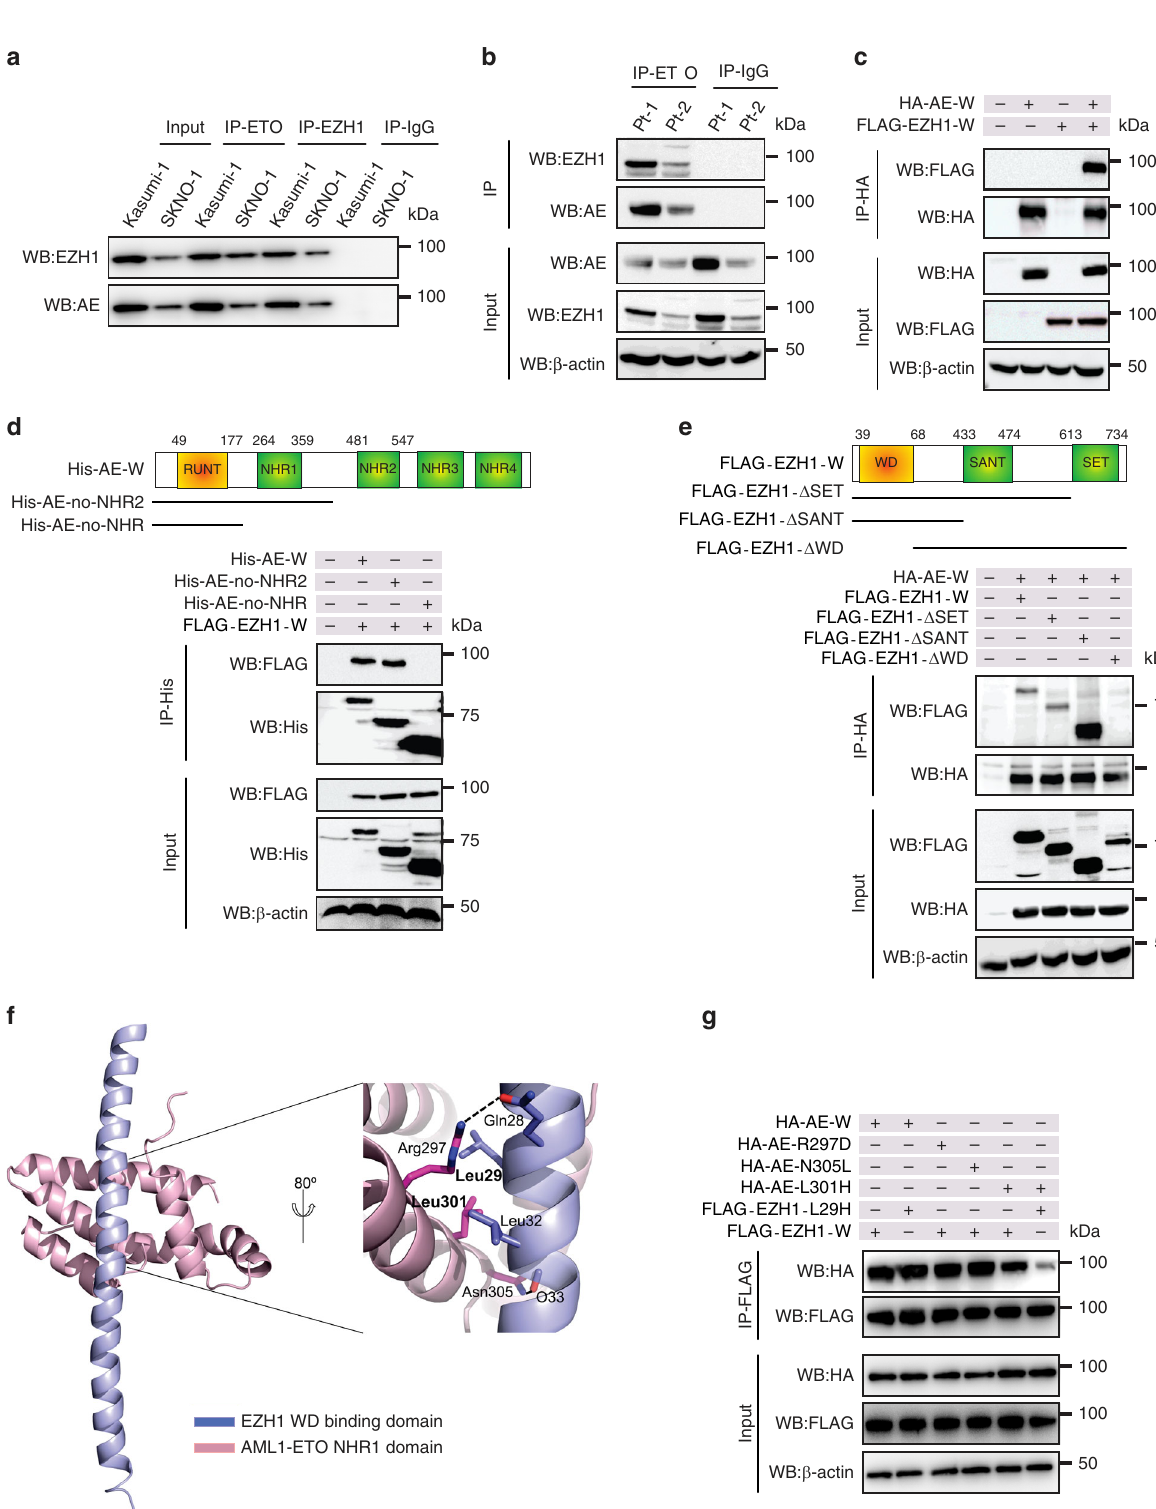
upper). The AML1-ETO pulldown with anti-His revealed a ETO itself can interact with EZH1, but no methylation was comparable lysine methylation for AML1-ETO full length detected in cells co-expressing FLAG-ETO-W (wild type) and His-EZH1-W (wild type) (Supplementary Fig. 4f). Moreover, (Fig. 4d, lane 1) and mutants with deletion of NHR2 or RUNT (Fig. 4d, lanes 3 and 4). However, deletion of the NHR1 domain AML1-ETO9a exhibited a higher level of lysine methylation when appeared to abrogate AML1-ETO methylation (Fig. 4d, lane 2), co-expressed with EZH1 (Fig. 4e, lane 3). Collectively, these fi ndings suggest that the site of AML1-ETO lysine methylation is indicating that the NHR1 domain is required for EZH1-induced methylation, which is in line with the fi nding that the removal of outside ETO, but within the AML1 portion. This conclusion was NHR1 disrupted the AML1-ETO-EZH1 interaction. Notably, further substantiated by our data showing that Lys43 substitution NATURE COMMUNICATIONS| (2019) 10:5051